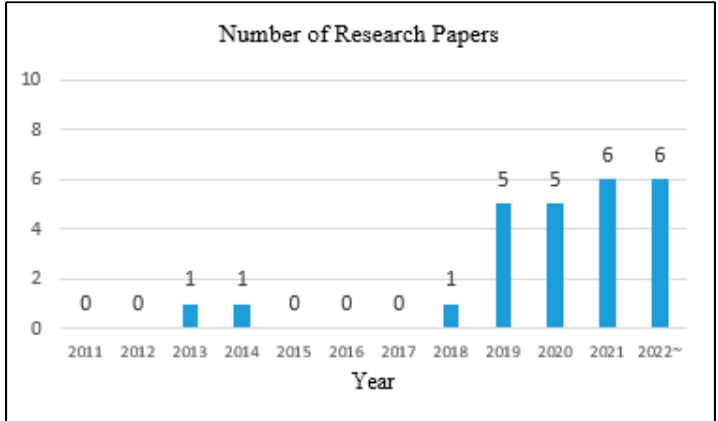
Figure 2. Number of research papers per